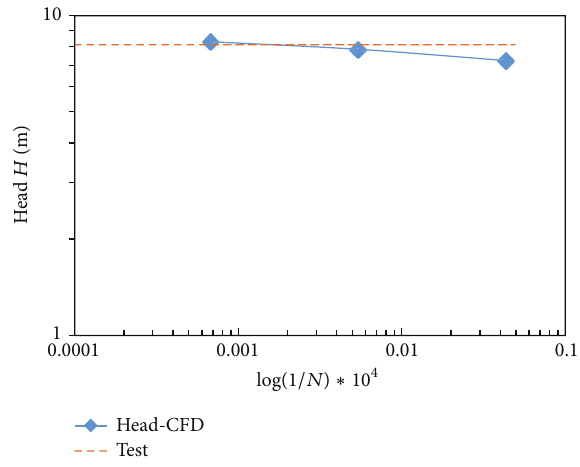
Figure 6: Head value under different mesh number.